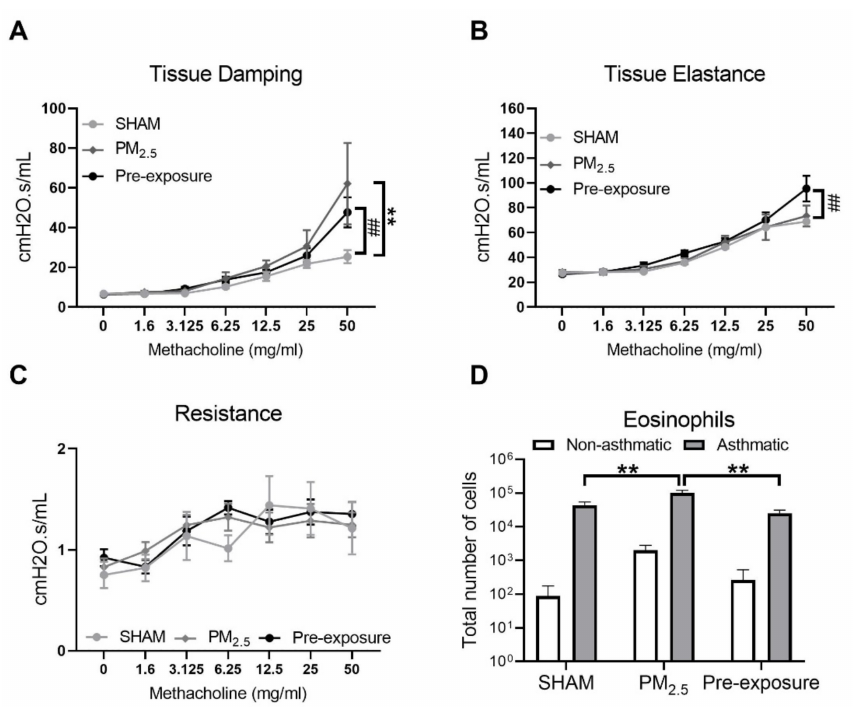
Figure 8. Maternal PM 2.5 exposure increased AHR in OVA sensitised animals. ( A ) Lung function of tissue elastance, ( B ) tissue damping and ( C ) resistance, and ( D ) eosinophil number in the BALF in response to OVA in the female offspring at 13 weeks. Data were analysed by two-way ANOVA (mixed-model) followed by Fisher’s LSD post hoc tests. Lung function was analysed by the two-stage linear step-up procedure of Benjamini, Krieger, and Yekutieli, followed by controlling the False Discovery Rate. n = 8. In (A, B) ** p < 0.01, PM 2.5 vs. SHAM. ## p < 0.01, Pre-exposure vs. SHAM. In ( D ), ** p < 0.01. PM 2.5 : mice exposed to PM 2.5 (5 µ g/day) prior to mating for 6 weeks during gestation and lactation. Pre-exposure: PM 2.5 exposure 6 weeks prior to mating. SHAM (OVA): offspring from SHAM dams challenged with OVA. PM 2.5 (OVA): offspring from PM 2.5 dams challenged with OVA. Pre-exposure (OVA): offspring from Pre-exposure dams challenged with